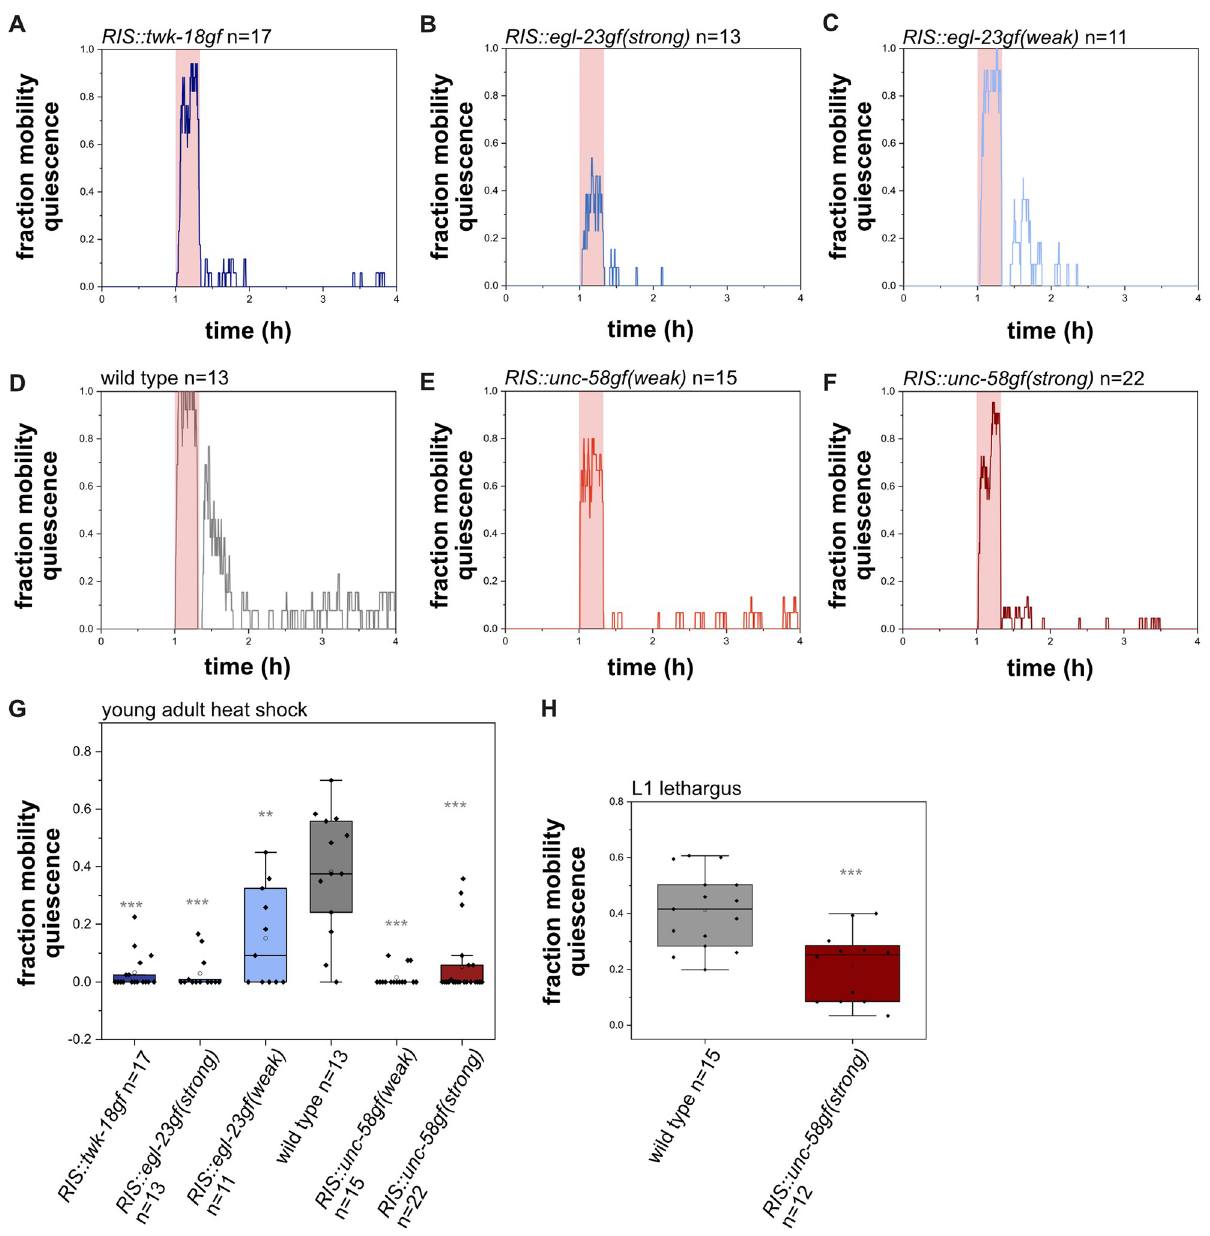
Fig 5. RIS :: unc-58gf impairs sleep following cellular stress and during the L1 molt in developing larvae. A-F) Sleep fraction of worms of different RIS activity strains during the heat shock experiment. Animals were recorded continuously throughout the experiment. First, a 1h baseline was recorded at 22˚C, then a 20 min heat shock period of 37˚C (in red shade) was applied, after the heat shock, the temperature was lowered to at 22˚C again to monitor the response to the heat shock. G) Quantification of time spent in sleep 20 min after the heat shock. Wild-type worms sleep on average 38.3%. All other RIS manipulations reduced quiescence. RIS :: unc-58gf(strong) only sleeps on average 6.5% of the time. �� p < 0.001, ��� p < 0.001, Welch test with FDR correction for multiple testing. H) RIS :: unc-58gf(strong) reduces lethargus sleep compared to wild type. ��� p < 0.001, Welch test. To test for sleep that occurs during development, we quantified behavioral quiescence of RIS :: unc-58gf(strong) during lethargus in fed L1 larvae. Behavioral quiescence of RIS :: unc-58gf (strong) was significantly reduced compared with the wild type. The loss of sleep behavior in lethargus was, however, not as strong as during L1 arrest or following stress-induced sleep (Fig